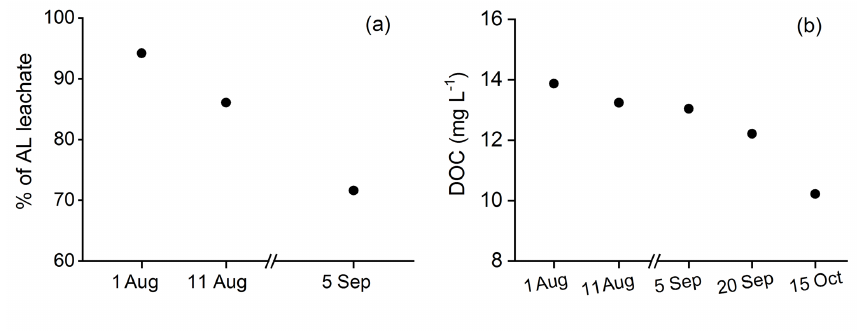
Figure 6. (a) Relative contribution of AL leachate DOM to headstream DOM (Q-1); and (b) temporal variation of the DOC concentration at headstream